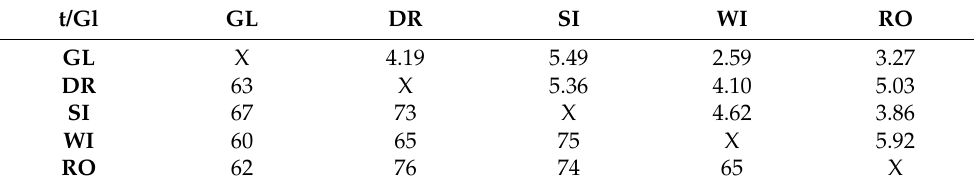
Table 4. Convergence of Sawara cypress local chronologies as measured with t and Gl (%) values.